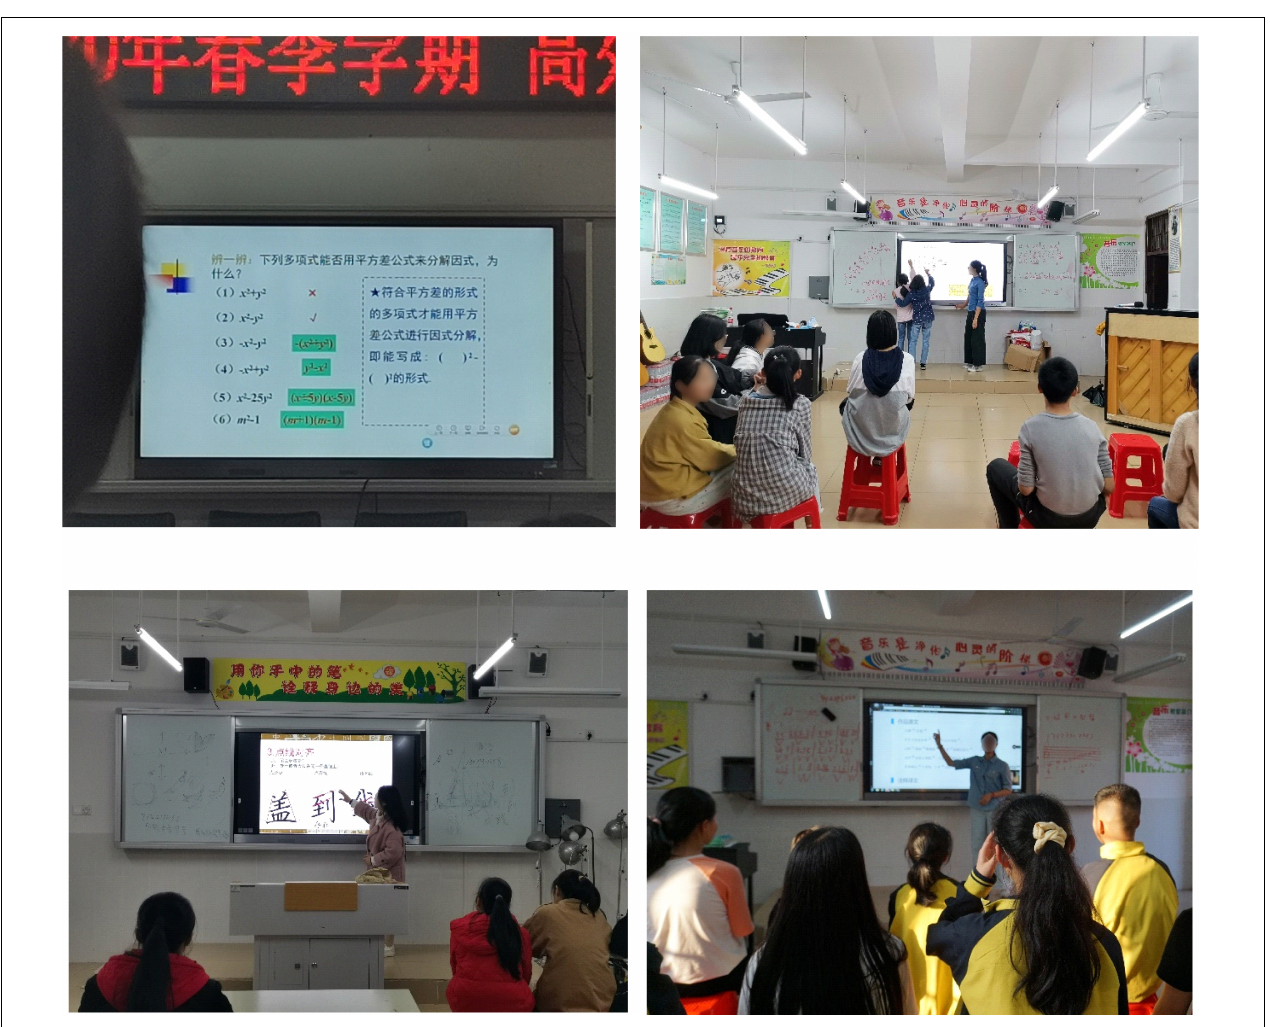
FIGURE 1 | The IWB supporting interactive teaching methods in the